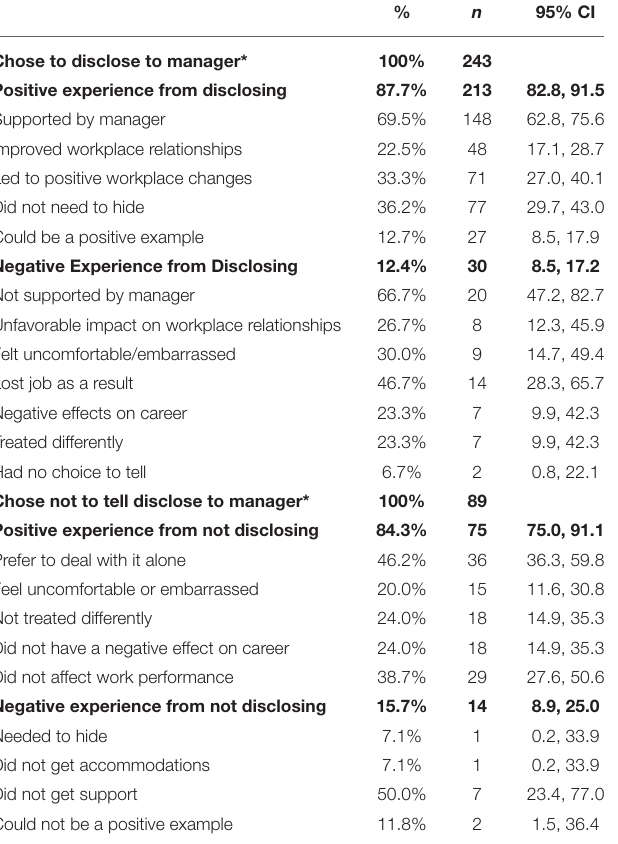
TABLE 2 | Disclosure decision and reasons by experience with mental health problems.